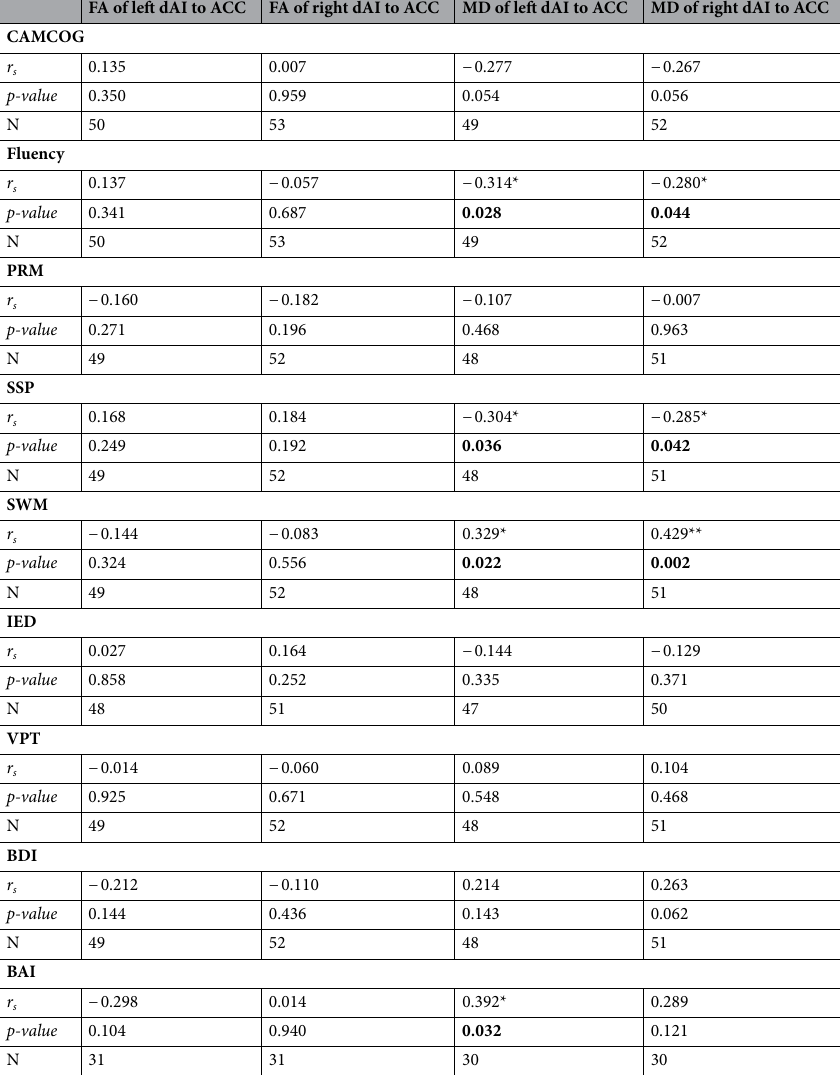
Table 3. dAI-ACC WM tract microstructural feature association with cognitive and affective measures in PD. r s = Spearman correlation; vAI = ventral anterior insula; dAI = dorsal anterior insula. CAMCOG = CAMbridge COGnitive examination revised test battery; PRM = pattern recognition memory; SSP = spatial span; SWM = spatial working memory; IED = the intra-extra dimensional set shift test; VPT = Vienna perseveration test; BAI = Beck Anxiety Inventory; BDI = the Beck Depression Inventory. * p < 0.05, ** p <